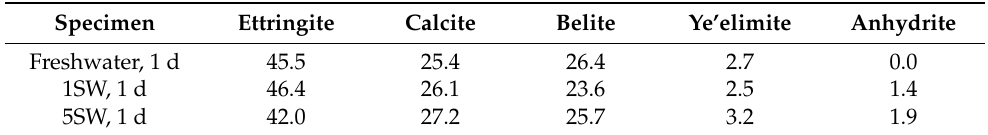
Table 5. Rietveld results (wt %) for the CSA cement mixed with different types of water and cured for 1